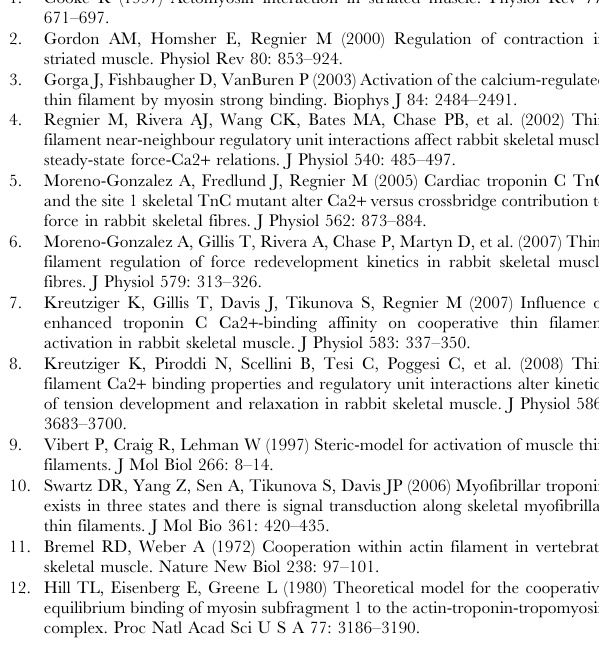
the A-band (B). Each filament also consists of a helical pitch describing myosin cross-bridges (XBs) extending from the thick filament or the intertwined filamentous actin helices, along which the thin filament regulatory proteins are located (C). Our accounts for these structural components of the muscle. Figure S2 Multiple cooperative pathways combine to produce the physiological force-pCa relationship. Sensitivities of force and fractional thin filament activation are illustrated for all combinations of kinetic cooperativity. (A) Lines show 3-parameter Hill fits to steady-state force-pCa responses for r t,12 being targeted indepen- dently, along with symbols depicting n H (B) and pCa 50 (C) values from fits to both force-pCa and fraction available-pCa relationships. Comparable simulation results are shown for r t,23 being targeted independently (D–F), or r t,12 and r t,23 being targeted in combination (G–I). Dashed lines illustrate simulation results in the absence of cooperative kinetics. Error bars represent 95% confidence intervals on the fitted parameter values for all panels. All simulations used standard parameter values of k xb =3 pN nm 2 1 , k fil = k m = k a =1X, and RUspan =9 actins, combining all possible forms of cooperativity. Figure S3 Cooperative thin filament activation kinetics slow the rate of thin filament activation. The rate of thin filament activation ( k TF,act ) is plotted against pCa, illustrating that kinetic forms of cooperativity considerably slow thin filament activation compared to simulations with no cooperative thin filament activation kinetics. In the presence of cooperative kinetics, XB binding also increased k TF,act . In the absence of cooperative kinetics, XB binding had a minimal effect on k TF,act (inset). All simulations used standard parameter values of k xb = 3 pN nm 2 1 , k fil = k m = k a =1X, and RUspan = 9 actins.